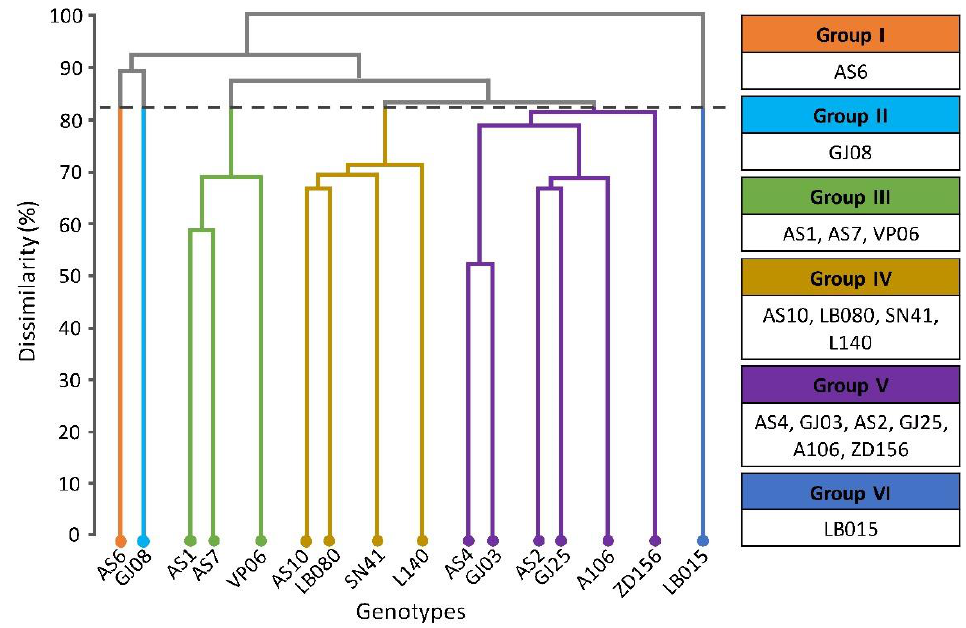
Figure 1. Dendrogram representing the genetic dissimilarity among 16 Coffea canephora genotypes based on the UPGMA grouping method and using the Euclidean distance to analyze the nutrient concentrations in the flower, grain, husk, and leaf tissues. Cophenetic correlation: 0.68. Subtle differences between the clustering methods were observed. Tocher’s